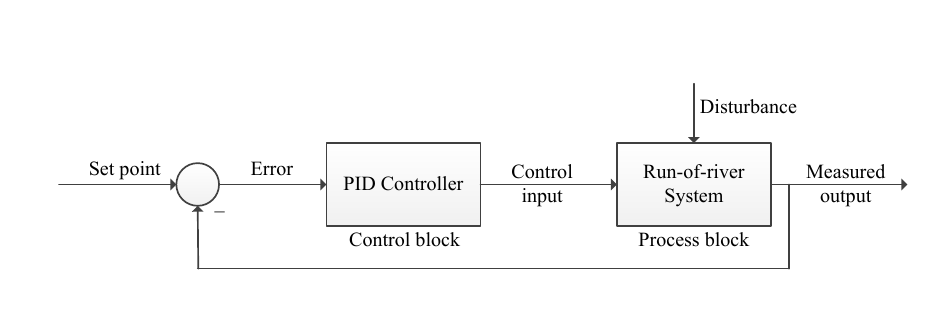
Figure 4: Control loop for the